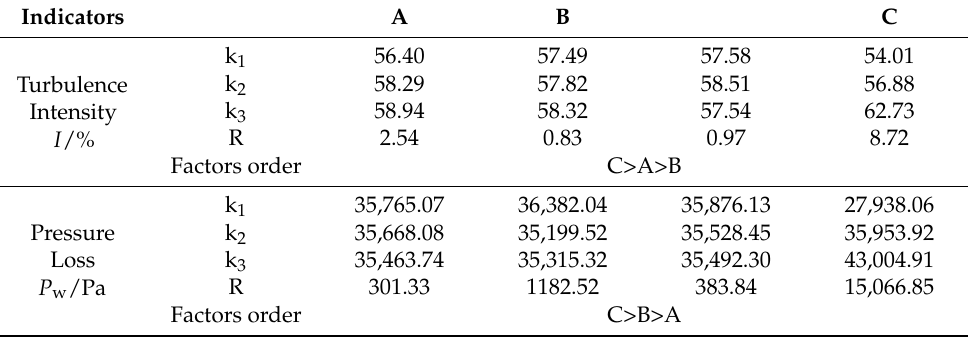
Table 6. Range analysis table.